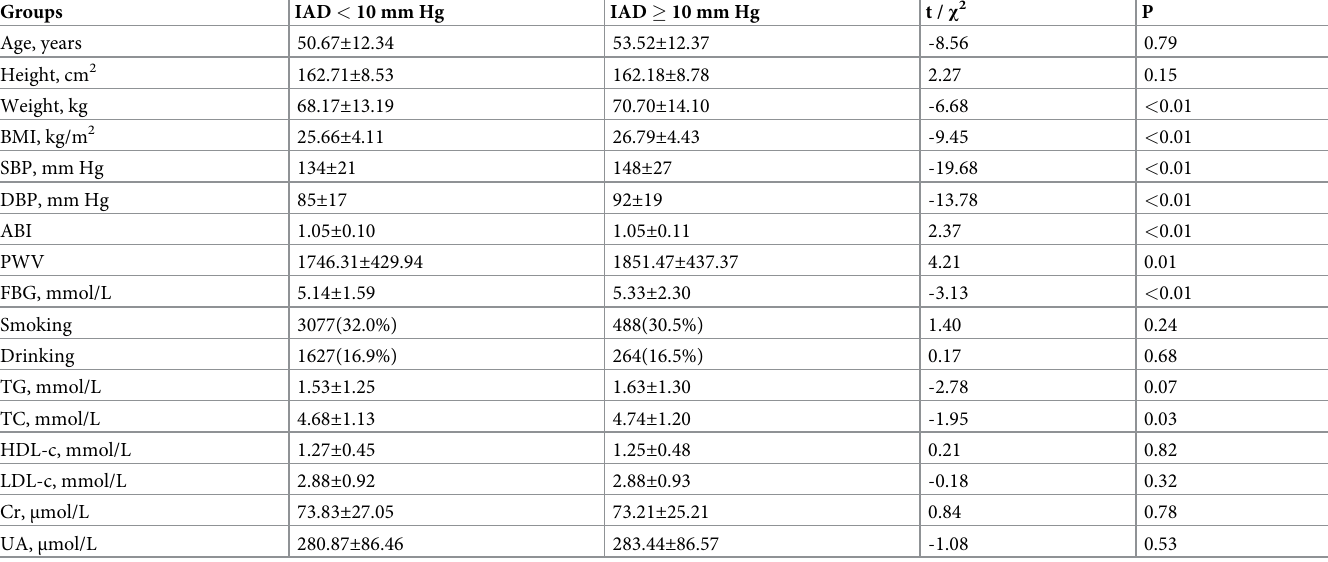
Table 2. Distribution of epidemiological data of IAD normal and abnormal groups. Groups